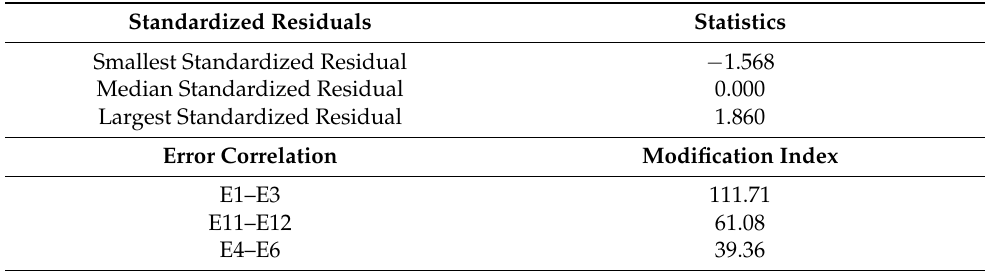
Table 5. Summary Statistics for Standardized Residuals and Largest Modification Indexes for Model 1.